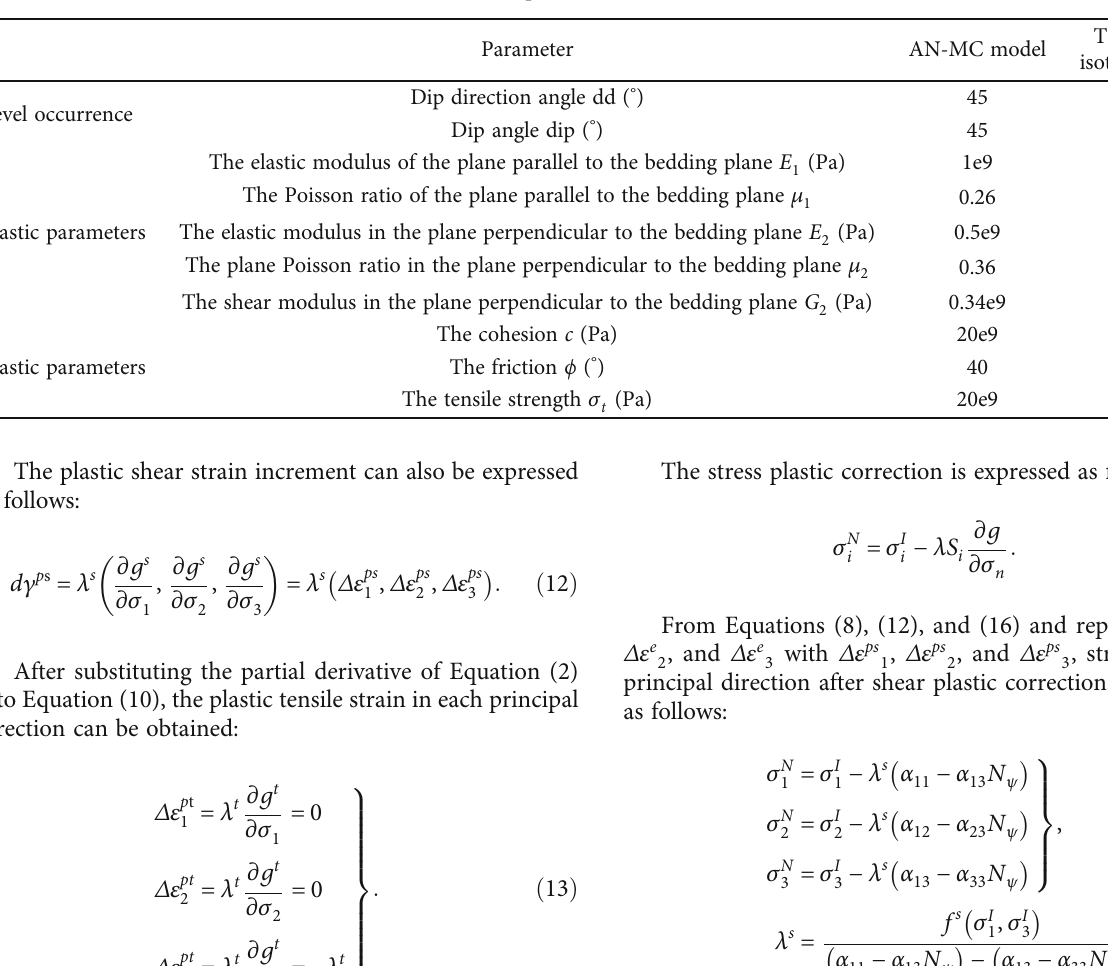
Table 2: Calculation parameters of constitutive model